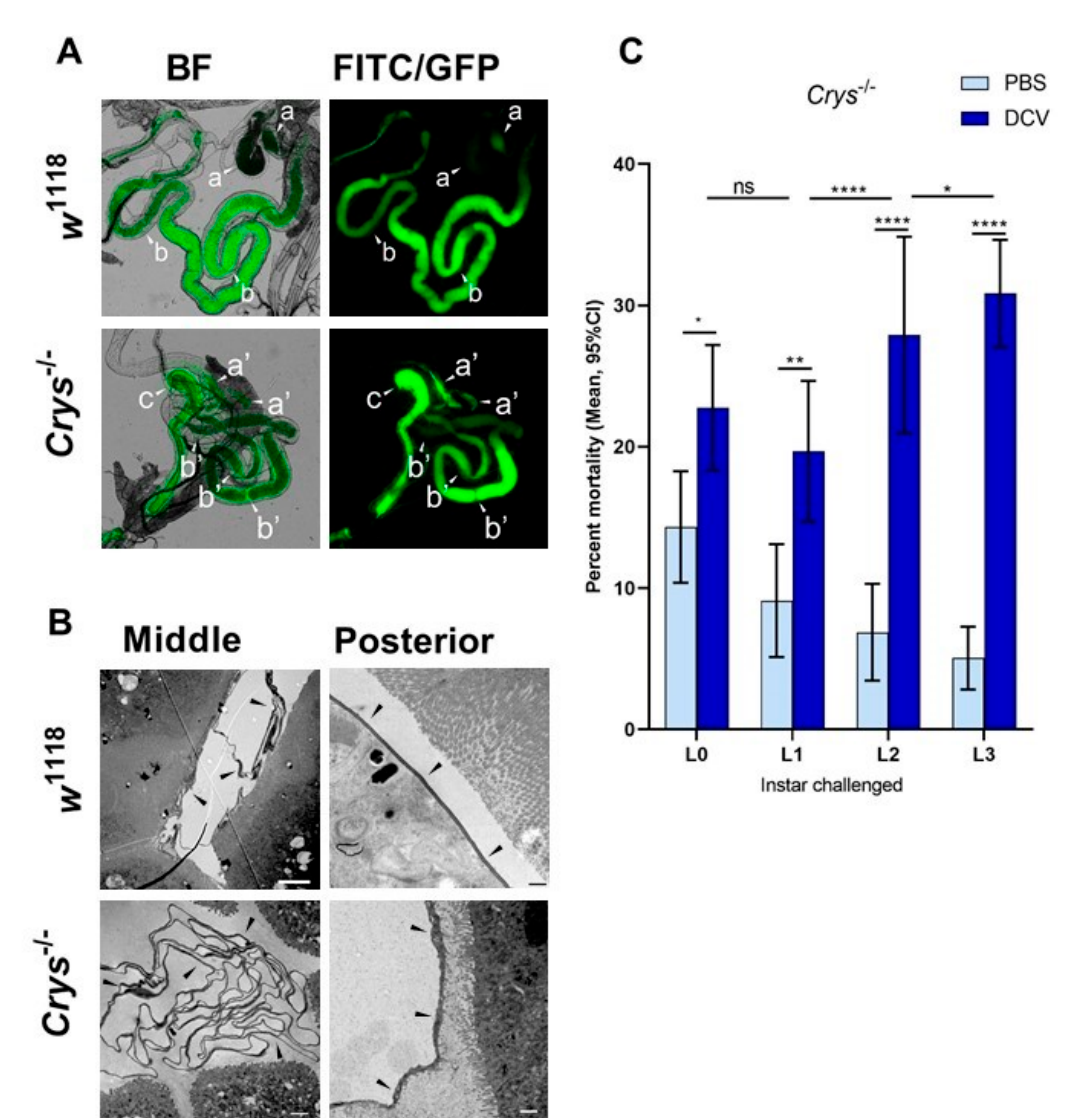
Figure 4. The loss of Crys increases the permeability of the larval PM, and increases the mortality of older larvae after oral DCV infection: ( A ) using bright field (BF) and fluorescence microscopy, the crossing of FITC-labelled DCV-sized particles out of the PM and into the gut lumen was observed more commonly in the middle midgut of Crys − / − larvae than in their w 1118 counterparts (pointers a, a’). In contrast, the PM of the posterior midgut was permeable to DCV-sized particles in almost every gut analysed (pointers b, b’). The transgenic 3xP3-EGFP marker in Crys − / − larvae was observed in the same fluorescence channel used for FITC, and used to confirm the Mi{ET1} cassette insertion. The promoter of this marker is reported to be brain- and eye-specific [64]; however, it also produces a signal in the hindgut (pointer c). ( B ) Using TEM, we evaluated the thickness and structure of the PM (indicated by the pointers) in middle and posterior midguts of L3 larvae of w 1118 and Crys − / − larvae. In Crys − / − , the PM appeared diffuse, irregular, and tended to fold and accumulate in excess in the middle midgut. Bar in w 1118 -middle, 5 µ m; in w 1118 -posterior, 0.5 µ m; in both Crys − / − images, 1 µ m. ( C ) Upon oral challenge following the same protocol as in Figure 1A, we used a two-way ANOVA with Š í d á k’s test to compare PBS and DCV mortality at each time point. At all time points there was an increased mortality when larvae were fed with DCV lysates. Furthermore, after comparing the effect of PBS or DCV across time points using Tukey’s test, the mortality caused by DCV significantly increased when the oral challenge was done in late larvae (results of statistical analysis are detailed in Table S1; * p < 0.05, ** p < 0.01, **** p <